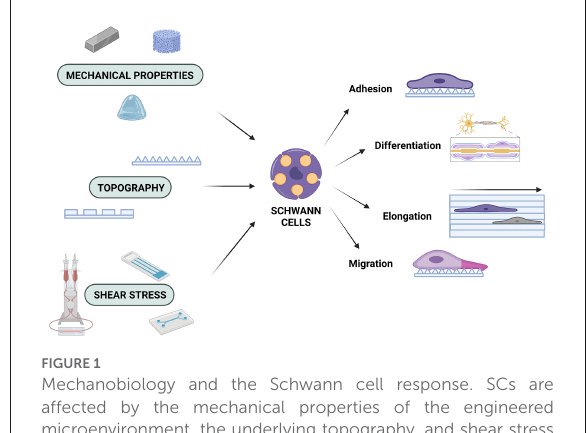
FIGURE1 Mechanobiology and the Schwann cell response. SCs are affected by the mechanical properties of the engineered microenvironment, the underlying topography, and shear stress forces, which can determine their adhesion profiles, their ability to migrate and/or elongate, as well as their capacity to differentiate. Created with